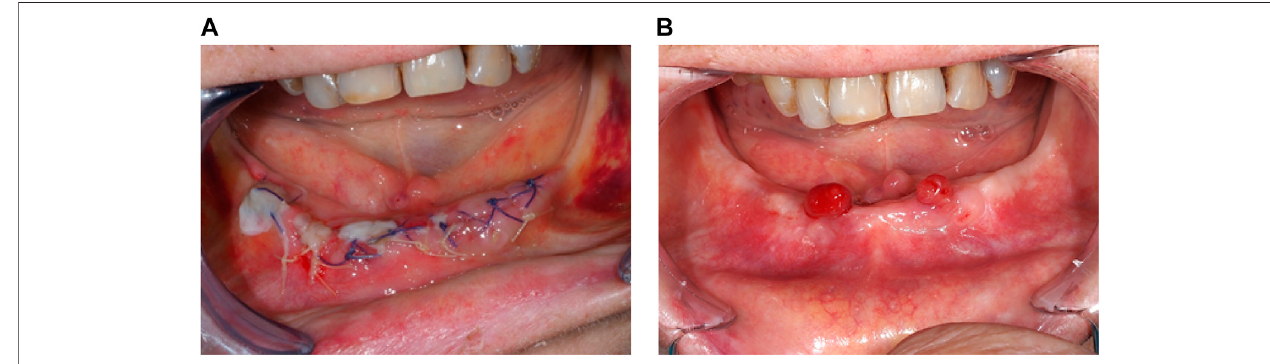
FIGURE 6 | Patient 5 (A) Wound healing beginning at Day 4. (B) Two painless and benign granulation tissues 4.5 months post-surgery.